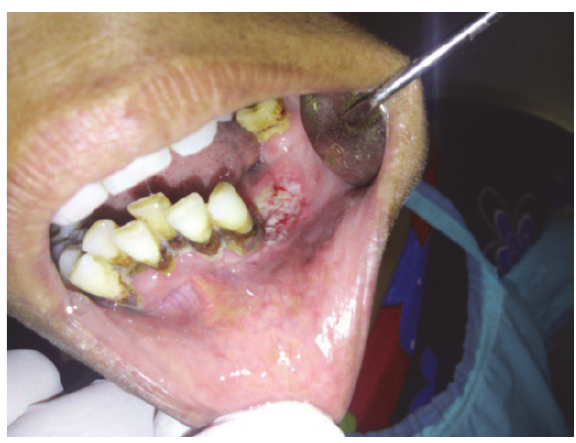
Figure 7: Eight-day postoperative